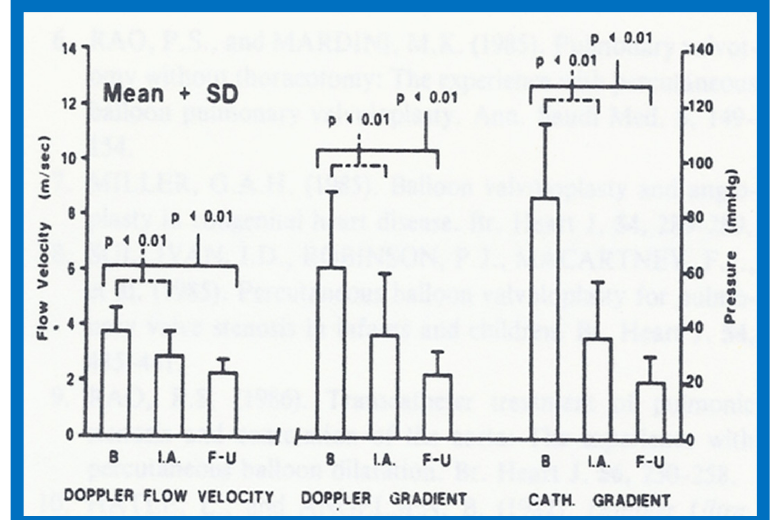
Figure 45. Bar graph showing Doppler flow velocity (left panel) in m / sec, calculated Doppler gradient (center panel) in mmHg and catheterization (CATH) measured peak-to-peak gradient (right panel) in mmHg before (B), immediately after (I.A.) and at a median follow up of 14 months (F-U) after balloon pulmonary valvuloplasty. Means and standard deviations (SD) are shown. Note that there is significant ( p < 0.01) decrease in Doppler flow velocity, calculated Doppler gradient and catheterization measured gradient both immediately after balloon pulmonary valvuloplasty and at follow-up. Reproduced from Rao P.S. [13].